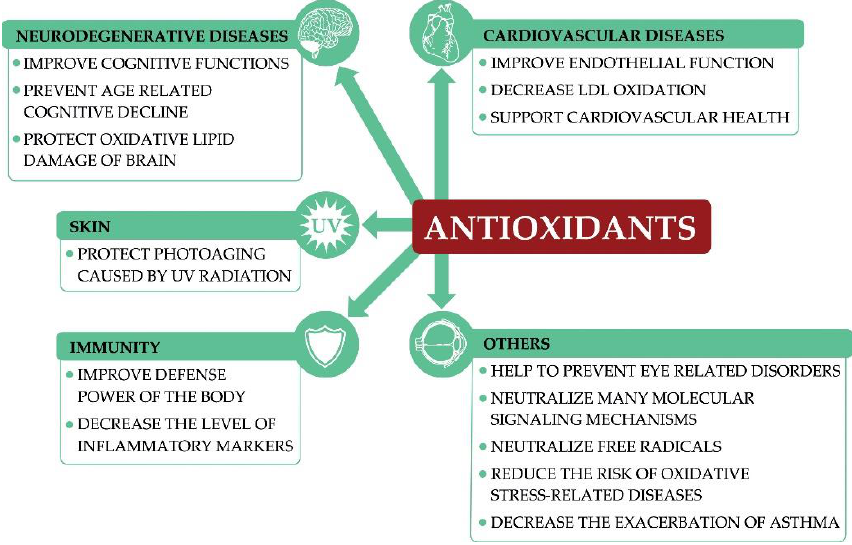
Figure 1. Influence of natural-source antioxidants on health.